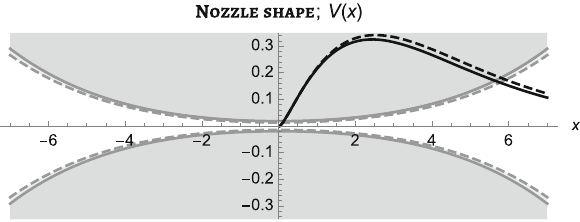
Fig. 2 The nozzle profile for s = (cid:20) = 1. The gray filled area , limited by the continuous ( dashed ) line denotes the de Laval nozzle in the Schwarzschild, GR σ → ∞ , limit (in the minimal geometric deformation of the de Laval nozzle). The black lines represent V ( x ) for the GR limit ( continuous line ) and its minimal geometric deformation ( dashed line )